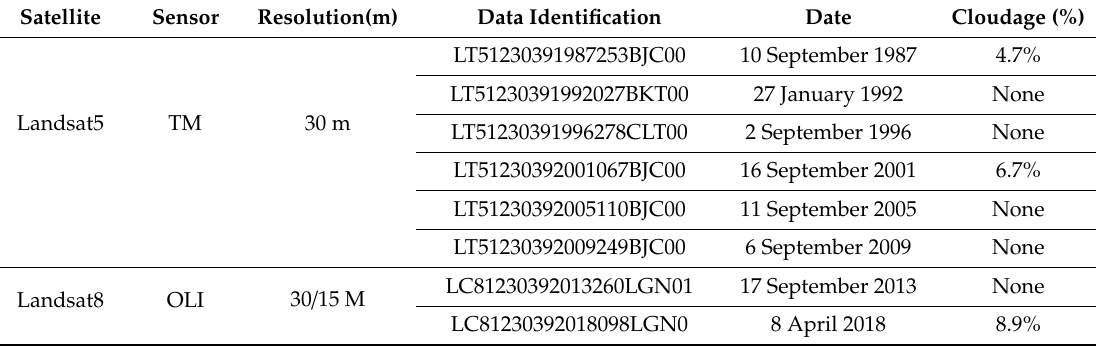
Table 2. The image data